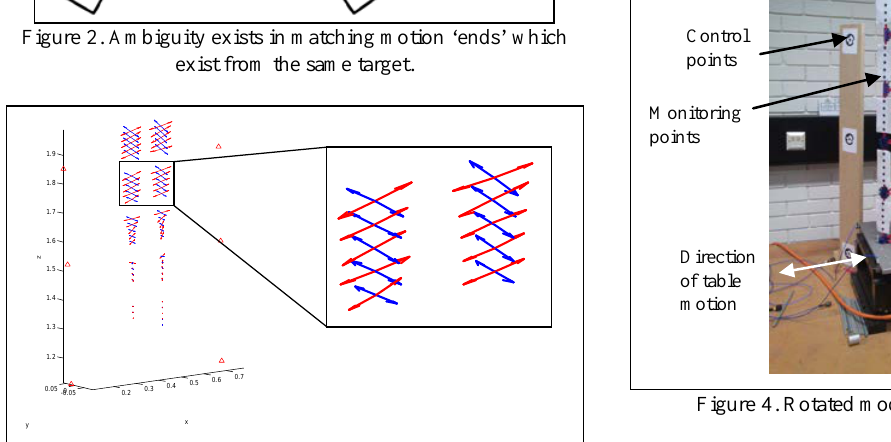
Figure 2. Ambiguity exists in matching motion ‘ends’ which